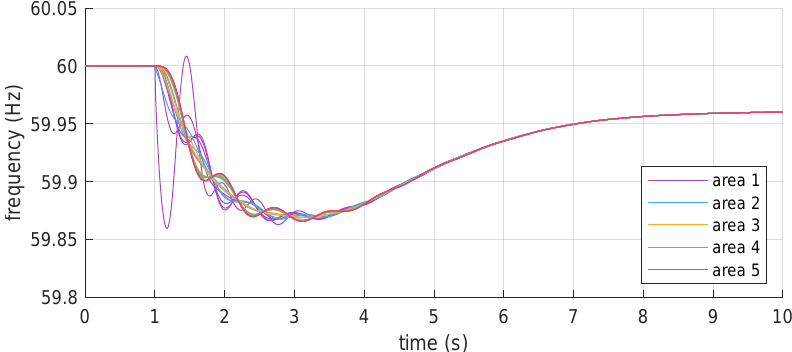
Figure 17. Simulation of the Colombian system: 50% grid-following with synthetic inertia.